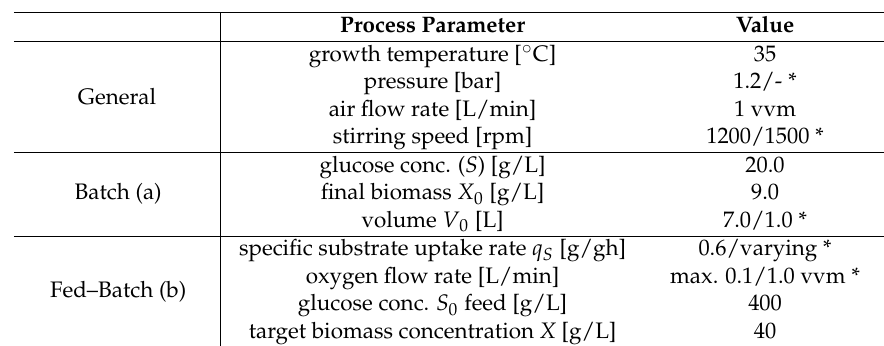
Table 1. Cultivation parameters for batch (a) and fed-batch phase